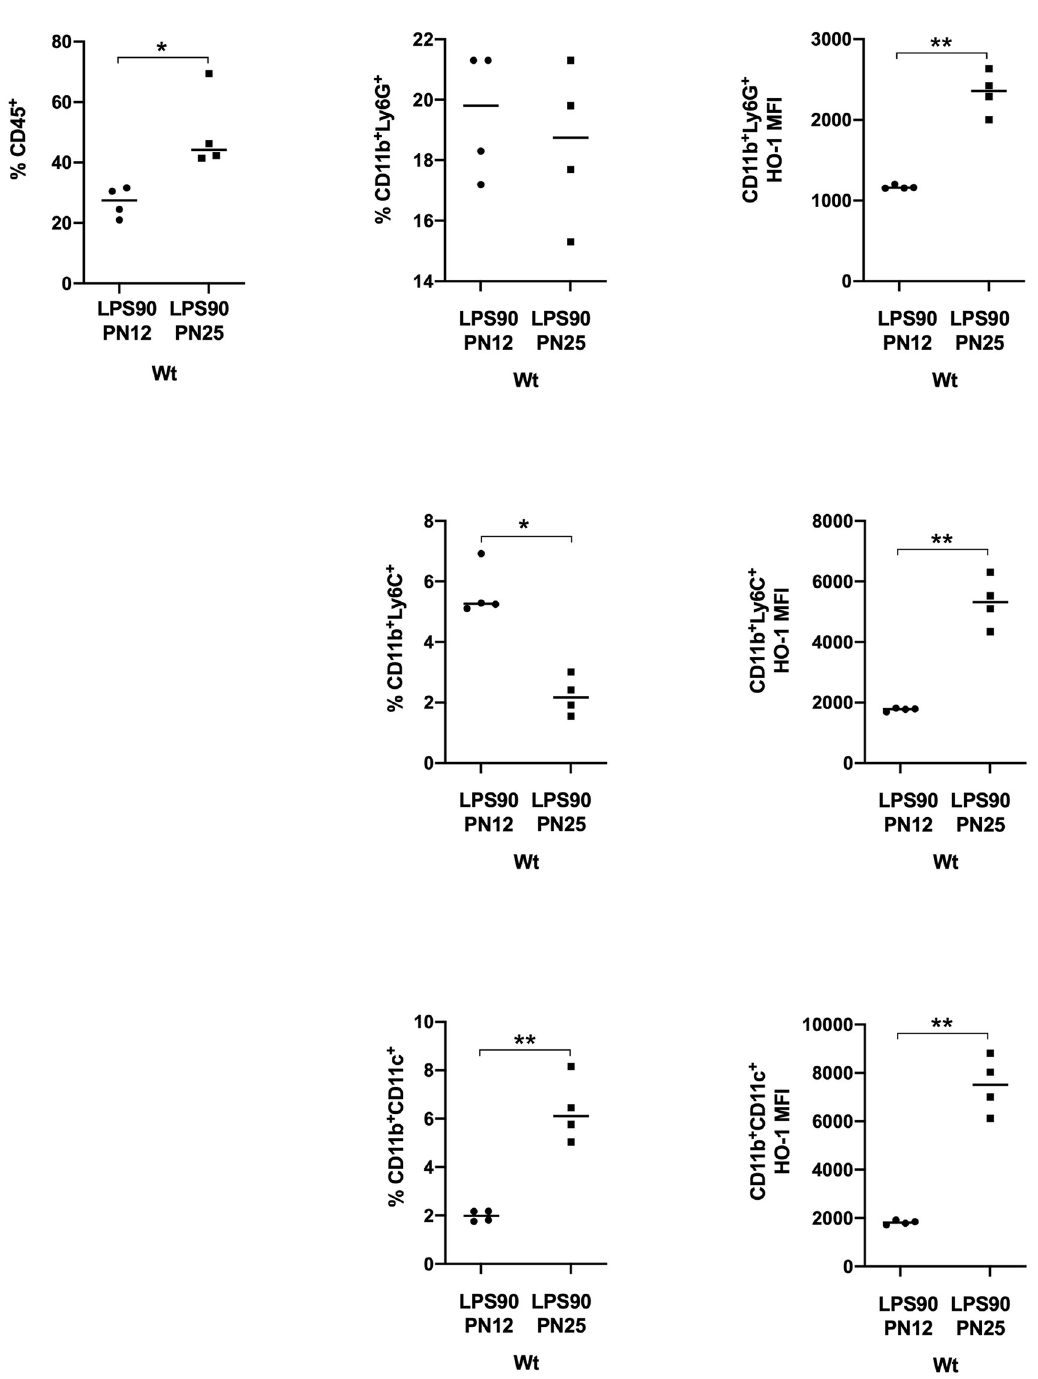
Fig 5. Innate immune responses at PN25 compared with PN12 in Wt offspring from dams exposed to LPS at a dose of 90 ug/ kg (LPS90) late in gestation. LPS administered i.p. to pregnant Wt dams at E15.5. Expression of splenic innate immune cells and intracellular HO-1 in Wt offspring were determined at PN25 by flow cytometry (Wt LPS90 PN12, n = 4; Wt LPS90 PN25, n = 4). CD45 + common leukocyte antigen. CD11b + Ly6G + neutrophils. CD11b + CD11c + DCs. CD11b + Ly6C + (mononuclear cells). Intracellular HO-1 expression in neutrophils, DCs, and monocytes. Cell populations are shown as percentages of CD45 + cells and intracellular HO-1 expression as median fluorescent intensities (MFIs). Values are expressed as mean ± SD, p < 0.05, Student’s t- test with Welch